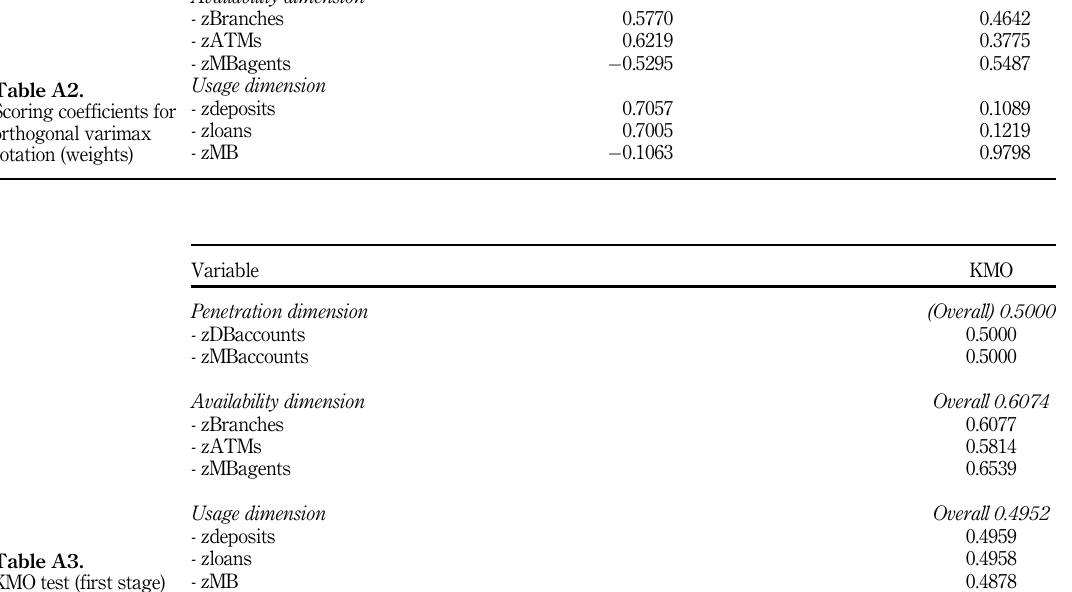
Table A3. KMO test (first